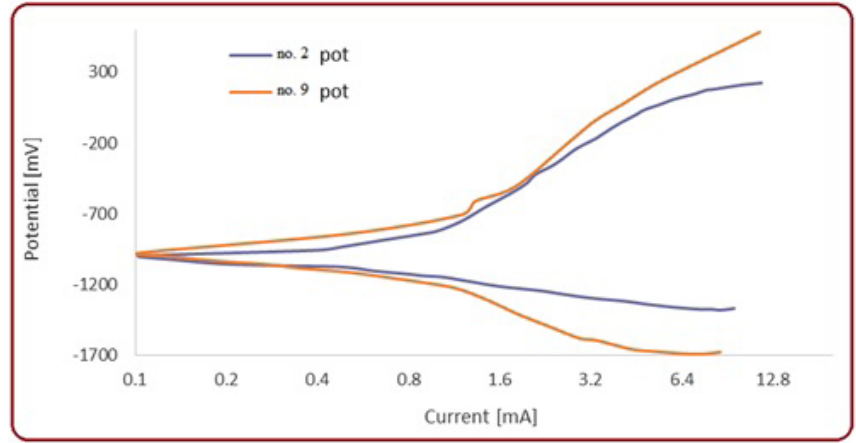
Figure 4. The potential study for samples 2 and 9.